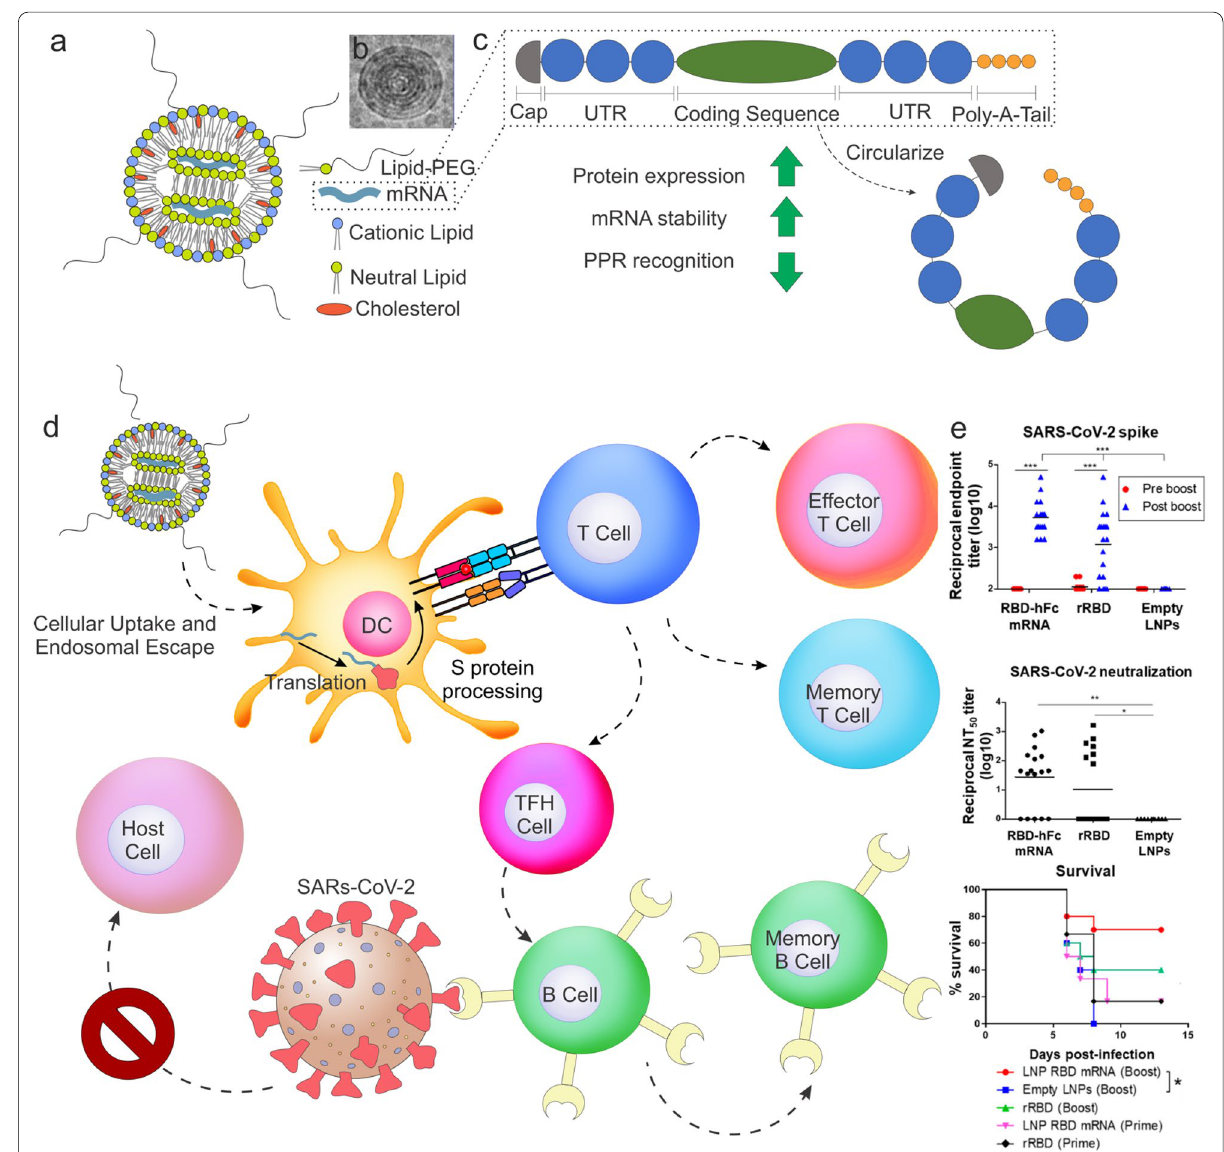
Fig. 8. mRNA modifications and delivery for viral vaccines. a General lipid nanoparticle formulations for mRNA delivery, peg‑ylated lipids improve circulation while cholesterol and cationic lipids provide structural stability and facilitate endosomal escape and cellular uptake, respectively. b Cryo‑EM image of a lipid nanoparticle. c Commonly utilized mRNA modifications that increase the efficacy of the delivered mRNA by increasing protein expression and mRNA stability while mitigating immune activation via pattern recognition receptors. d Mechanism of action for viral vaccines. Following delivery and cellular uptake of the mRNA encapsulated lipid nanoparticles , the transcript is able to escape the endosome and undergo translation, in this schematic the mRNA codes for the spike protein. T he spike protein is then processed by proteases and presented to T cells in lymph nodes via the MHC‑II and TCR complex. Next, T cells begin to proliferate and differentiate into effector T cells and T follicle helper cells that can stimulate B cells to produce antibodies specific o the spike protein antigen. Following future exposure to SARS‑CoV2, the patient’s immune system will be primed and capable of combating the virus. e Serum samples collected 23 days (“preboost”) and 46 days (“postboost”) from hACE2 transgenic mice treated following initial priming. Lipid nanoparticle RBD‑hFc mRNA treated mice display elevated SARS‑CoV‑2 spike‑specific IgG antibodies ( e1 ) and neutralizing antibodies ( e2 ) following the booster compared to mRNA delivered without a lipid nanoparticle and lipid nanoparticles without the target mRNA. f Survival of mice groups following treatment shows that boosted mice had a higher survival rate. g Weight of treated mice returned normal two weeks post booster for mice treated with lipid nanoparticle RBD‑hFc mRNA. Untreated mice did not survive past day 7. Reproduced with permission from ref [173,